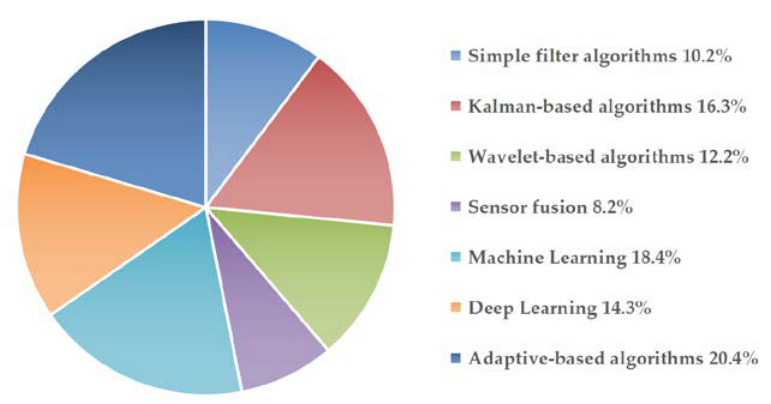
Figure 3. Proportions of the types of algorithms in the reviewed results.